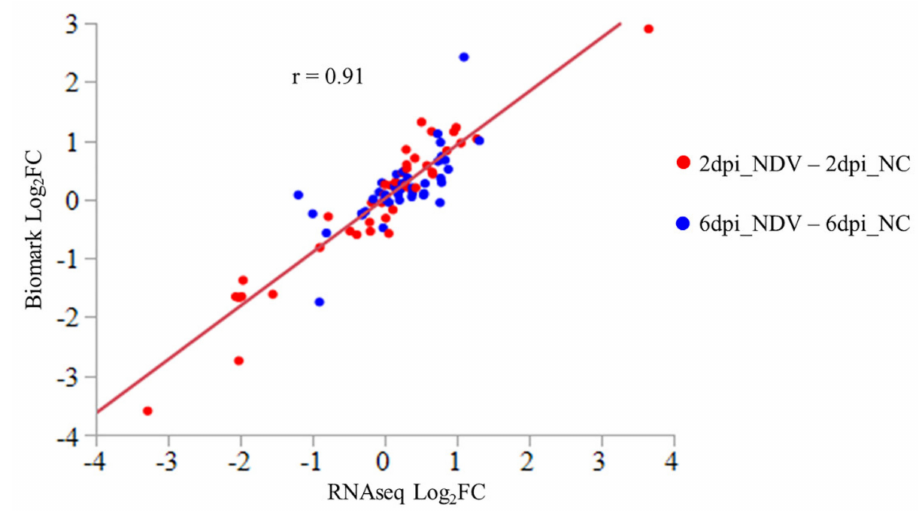
Figure 1. Gene expression analysis by Fluidigm Biomark assay of log 2 fold change (Log 2 FC) of selected genes that were significant for di ff erent contrasts in RNA-seq analysis. Contrasts between treatments at di ff erent time points are marked in di ff erent colors and each combination is labeled as Time_Treatment (dpi: day post inoculation; NDV: NDV-challenged, NC: Non-challenged). Pearson correlation coe ffi cient is labeled as “r”. Log 2 FC in Biomark assay equals − ∆∆ CT for each comparison. Average expression of three housekeeping genes, GAPDH , ACTB , and HPRT1, was used for normalization of Ct